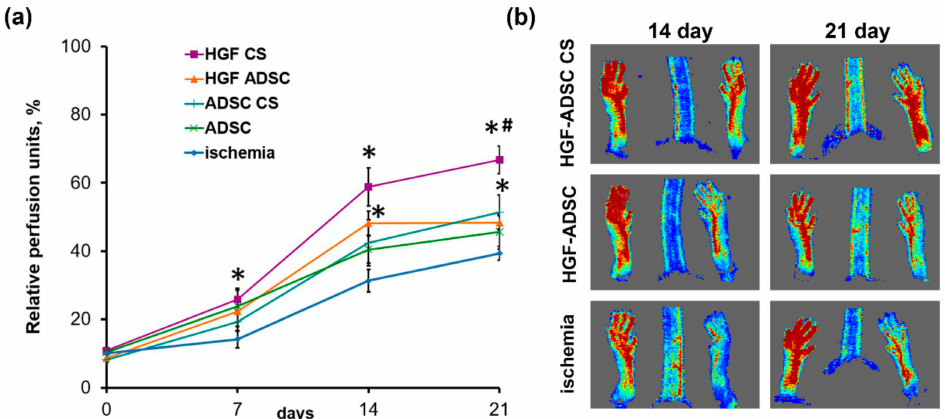
Figure 3. Blood flow recovery in ischemic mouse after transplantation of HGF-producing ADSC sheet. ( a ) Chart reflects dynamics of limb perfusion in ischemia group ( n = 9) or treated animals that received HGF-ADSC CS ( n = 10), ADSC CS ( n = 10), suspended HGF-ADSC ( n = 9) or ADSC ( n = 8); *- vs. untreated control, #- vs. HGF ADSC group. ( b ) Representative laser-doppler images of subcutaneous blood flow at day 14 and 21 after ischemia induction and constructs / cells transplantation. HGF = hepatocyte growth factor, CS = cell sheet, ADSC = adipose-derived stromal cells. 2.4. Increased Vascularization of Ischemic Skeletal Muscle after HGF-ADSC CS